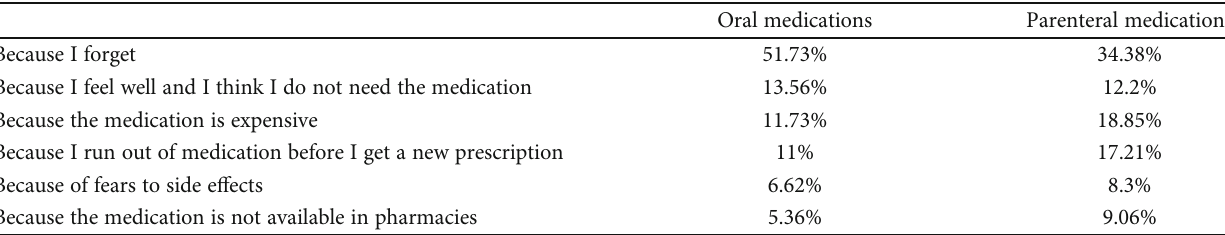
Table 6: Self-reported reasons of inadequate